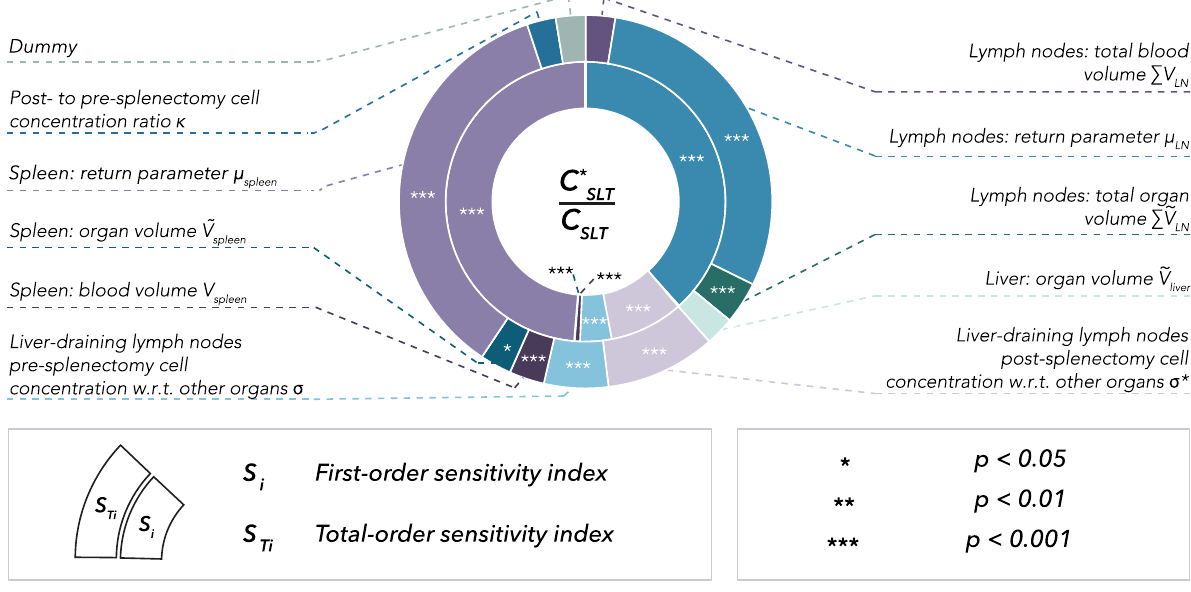
Figure 6. Results of the global sensitivity analysis eFAST on the post- to pre-splenectomy total T cell localisation to SLT ratio (upper) and the post- to pre-splenectomy net T cell concentration in SLT ratio (lower). The inner (outer) ring indicates the proportional size of individual sensitivity indices (total sensitivity indices). A dummy parameter is used as a baseline for statistical comparison and a p-value was assigned to each sensitivity index using a two-sample t-test 43 . Parameters with statistically significant sensitivity indices were labelled according to the assigned p-value ( ∗ , ∗∗ , ∗∗∗ ). The eFAST sensitivity analysis considered with a sampling of the lumped parameters κ , σ , σ ∗ from their distributions in Fig. 5a, cut off at the 95% confidence interval, together with the other parameters to be sampled uniformly, as detailed in “Global sensitivity analysis” section, with further details on parameter distributions in “Parameterisation” and “In silico splenectomy—simulation”